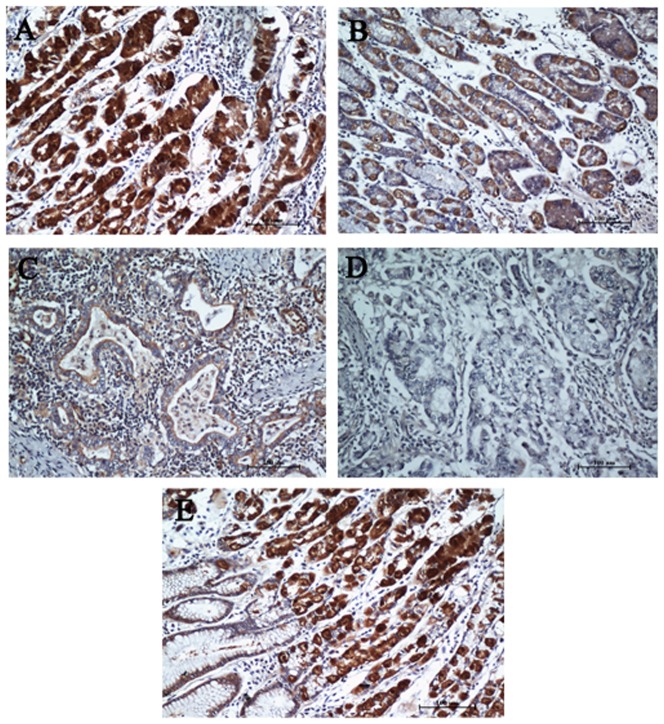

PTPRD protein expression in gastric adenocarcinoma surgical specimens evaluated by immunohistochemistry.(A) Strong PTPRD staining was observed in noncancerous gastric mucosa. (B) Strong PTPRD staining in well-differentiated gastric cancer. (C) Weak PTPRD staining in moderately differentiated GC. (D) Negative PTPRD staining in poorly differentiated GC. (E) Immunostaining of GC and adjacent nontumorous tissues showing a sharp contrast of PTPRD staining intensity.